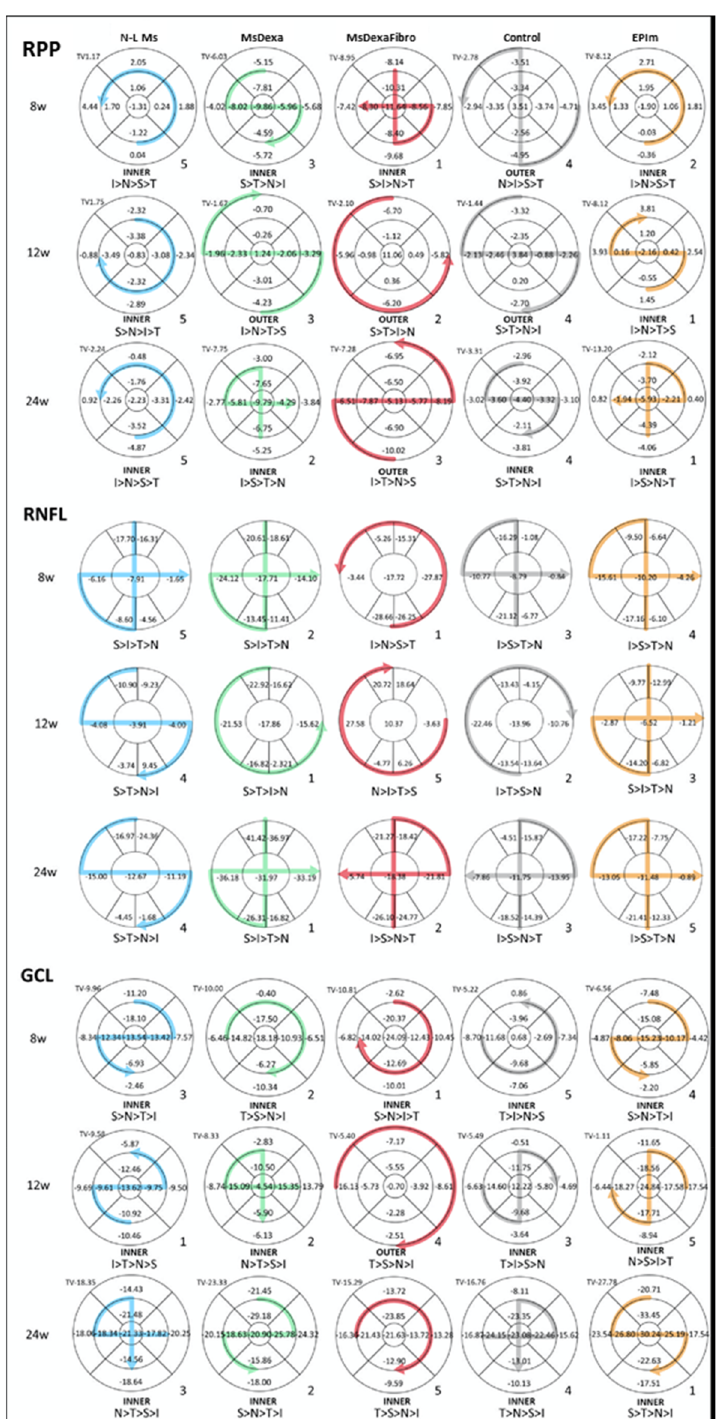
Figure 6. Percentage loss by optical coherence tomography sector and loss trend follow-up comparison among four chronic glaucoma models and healthy control cohorts. w week; RPP retina posterior pole; RNFL Retinal Nerve Fiber Layer; GCL Ganglion Cell Layer complex; TV total volume; > greater than; S superior; I inferior; N nasal; T temporal; N-L Ms cohort with non-loaded microspheres; MsDexa cohort with microspheres loaded with dexamethasone; MsDexaFibro cohort with microspheres loaded with dexamethasone and fibronectin; EPIm cohort with sclerosis of the episcleral veins. Grading: high (5) to low (1) based on total volume loss